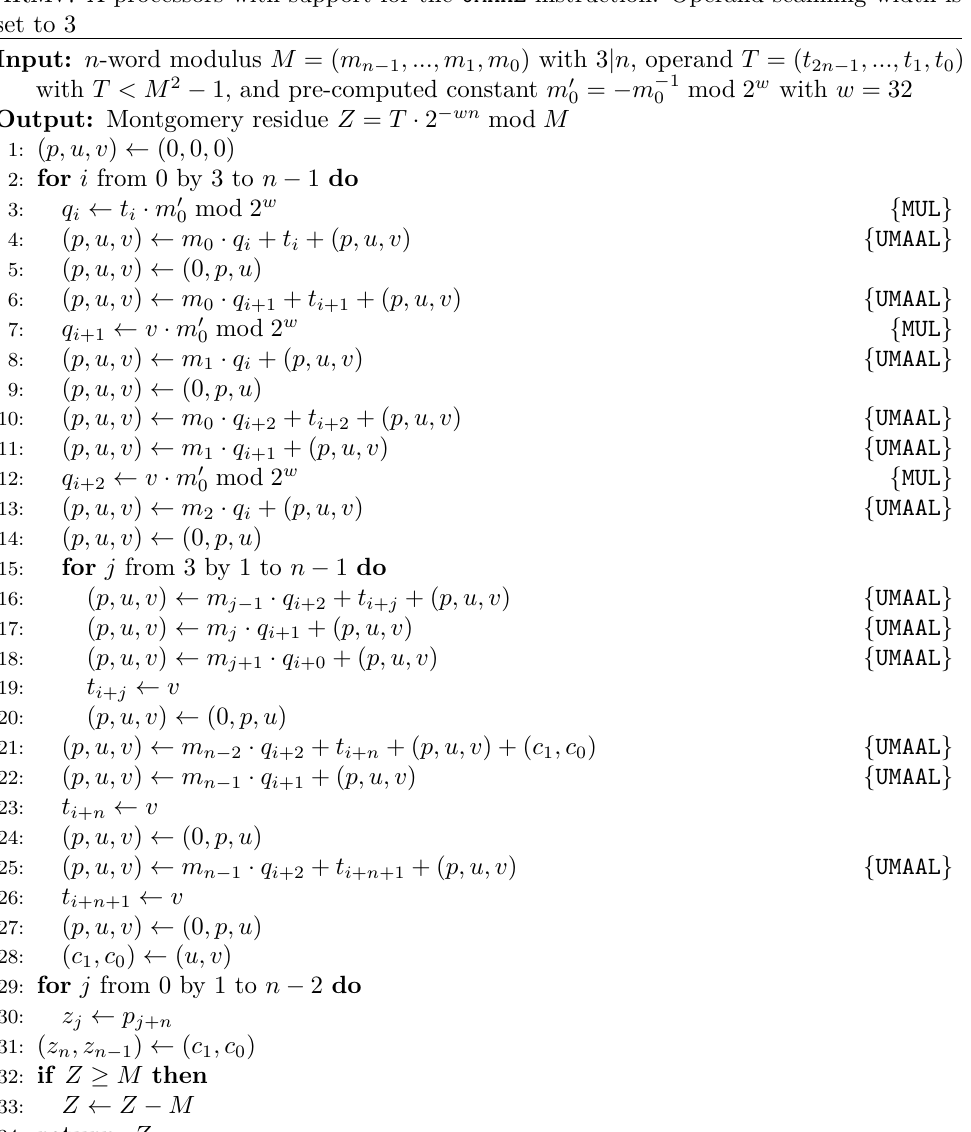
Algorithm 3 Hybrid-scanning algorithm for Montgomery reduction targeting